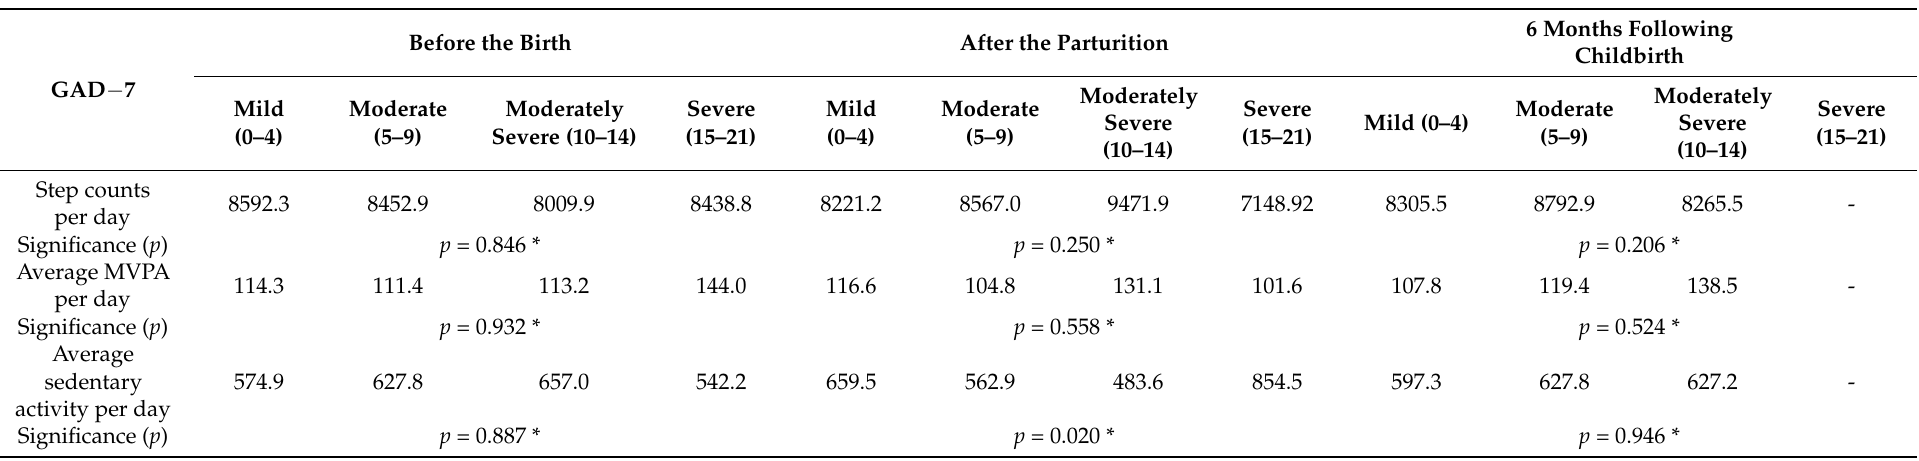
Table 4. The relationship between physical activity and the occurrence of anxiety